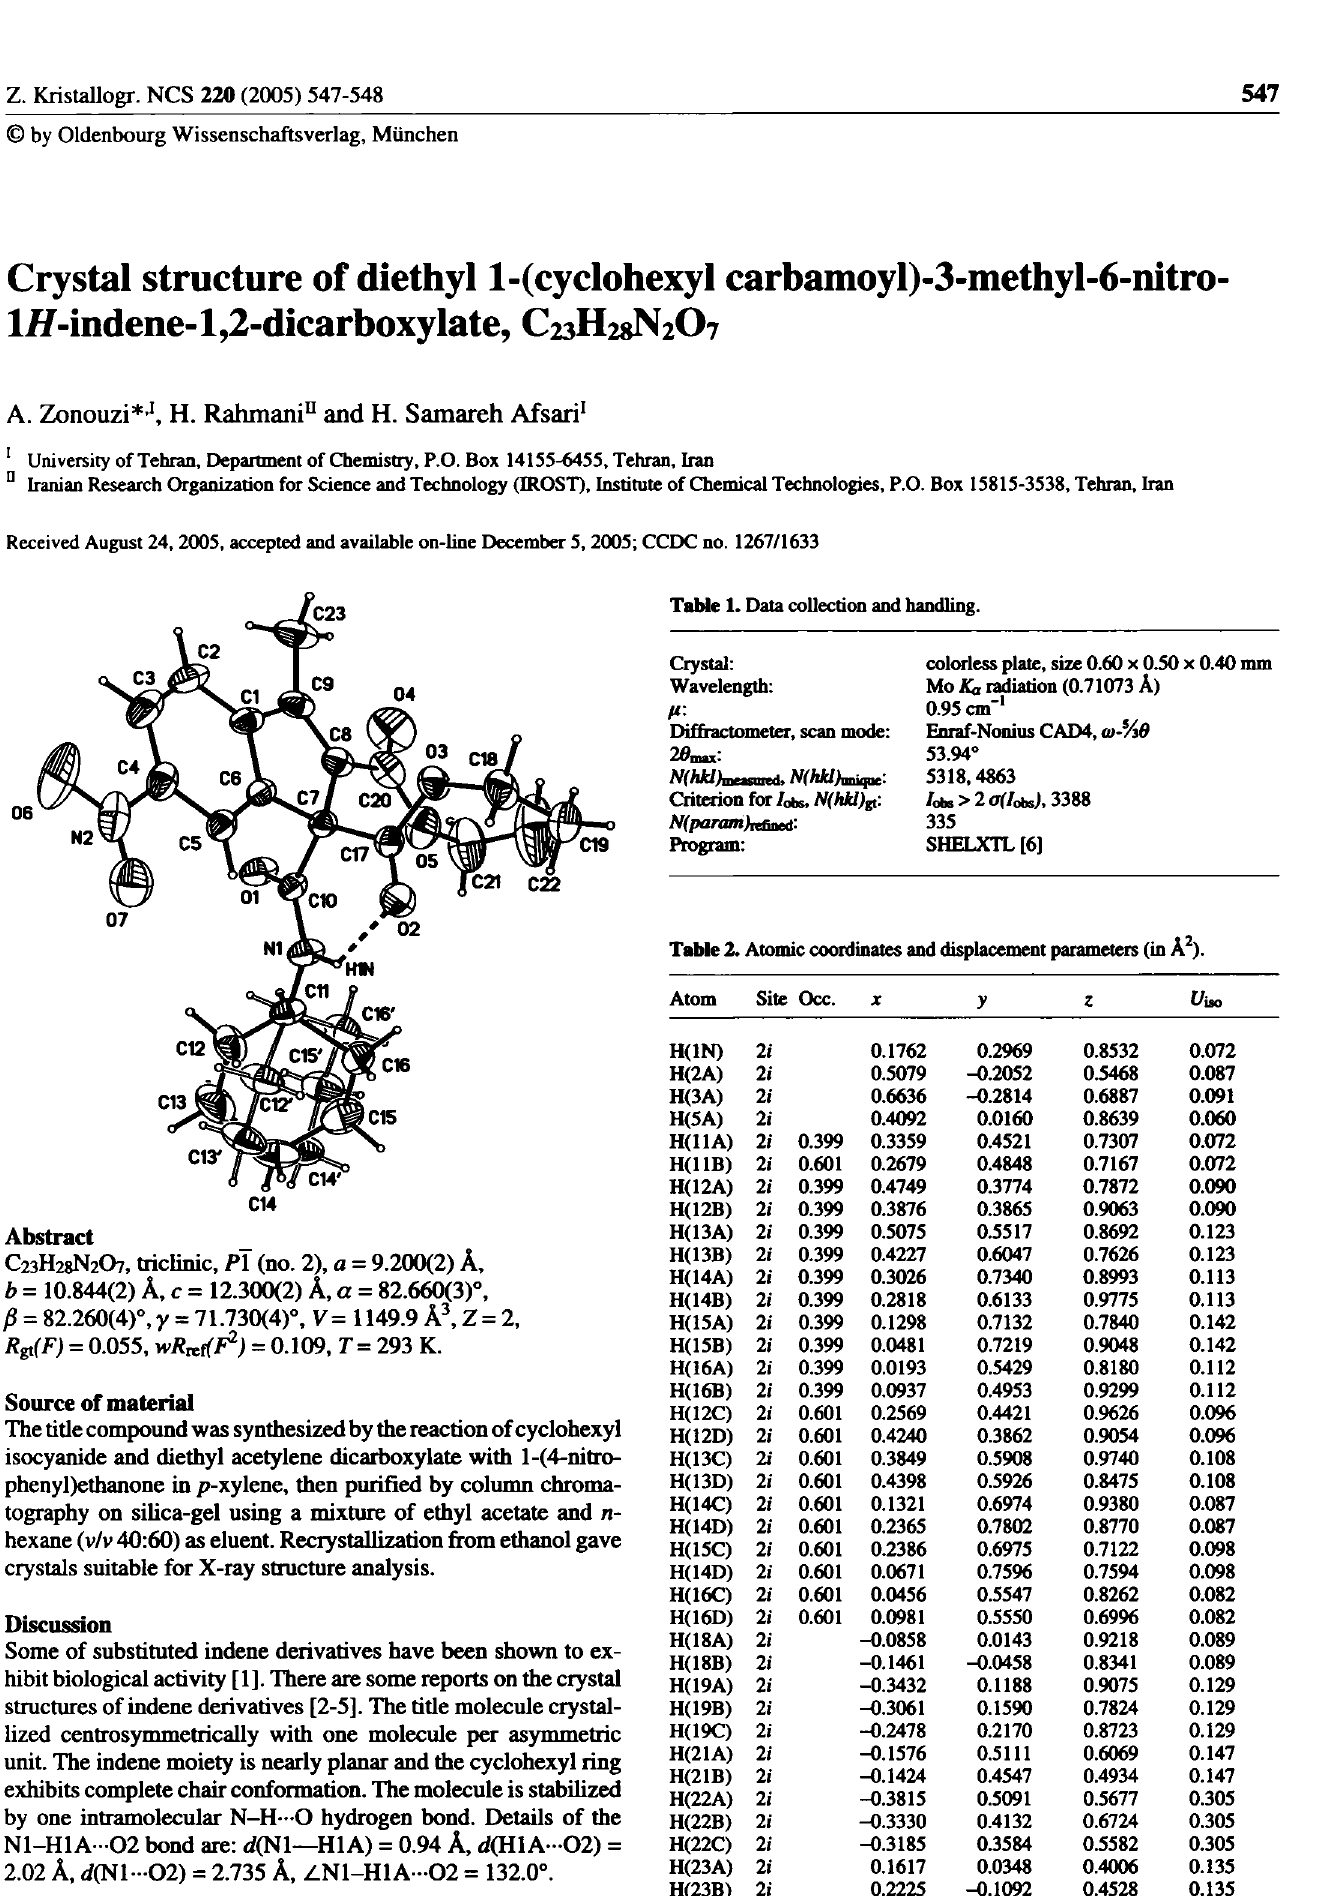
Table 2. Atomic coordinates and displacement parameters (in A 2